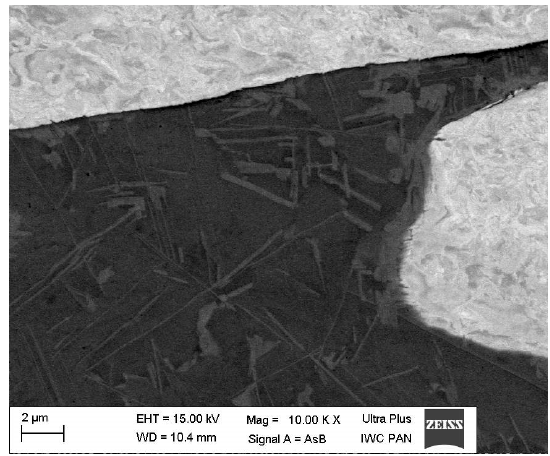
Figure 12. Fine needle-like precipitates in the matrix of the WNi6Co4 alloy (SEM); mag.—10000